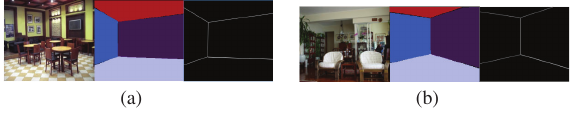
Figure 7. Example of spatial layout training